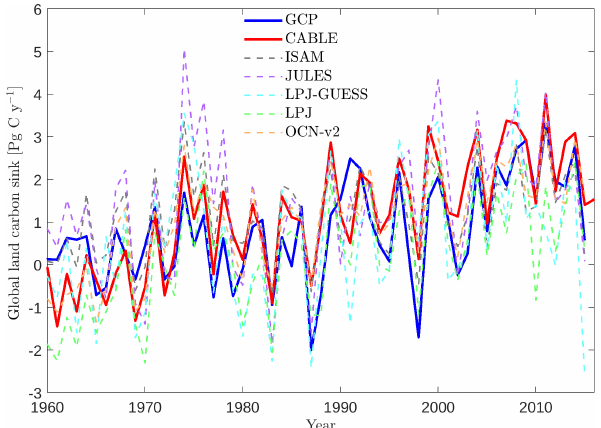
Figure 10. Global land carbon sink, as predicted by CABLE and five terrestrial biosphere models contributing to TRENDY-v5 (Le Quéré et al., 2016), and the Global Carbon Project (GCP) estimate, as the sum of atmosphere and ocean sinks minus fossil fuel emis- sions (Le Quéré et al., 2016).